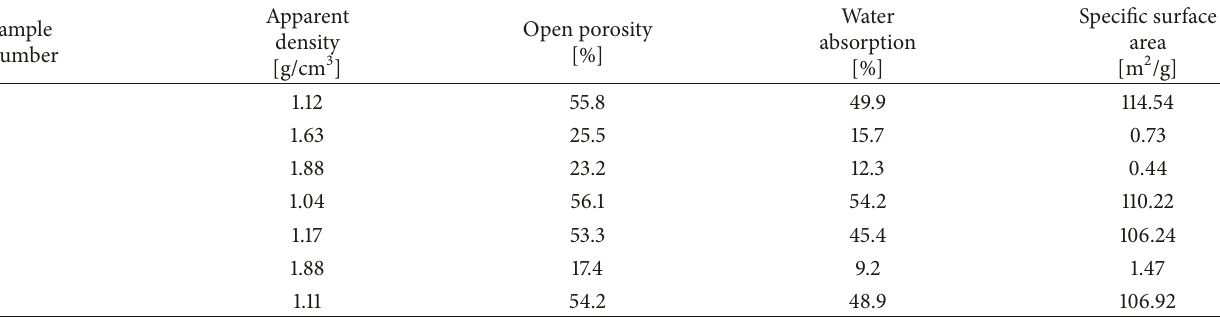
Table 3: Results of selected physical properties obtained for samples having compositions contained in Table 2 (obtained by firing at 600 ∘ C).